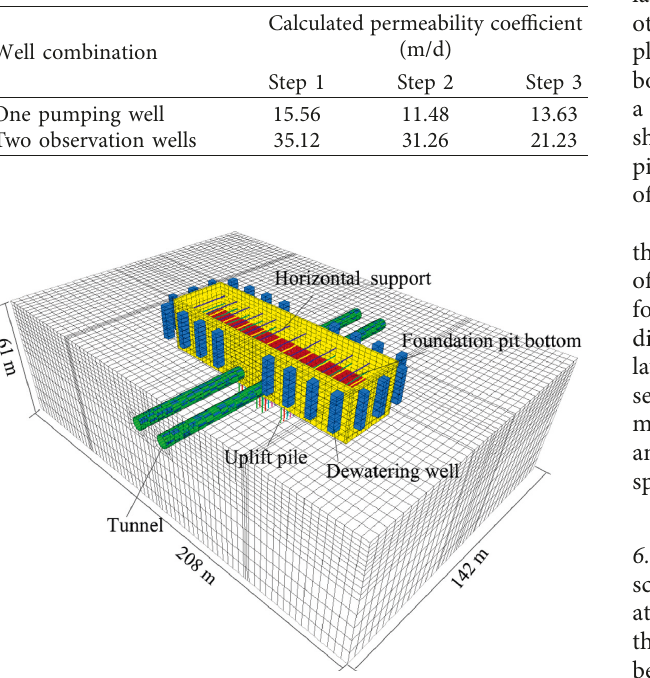
Figure 7: 3D numerical model diagram.